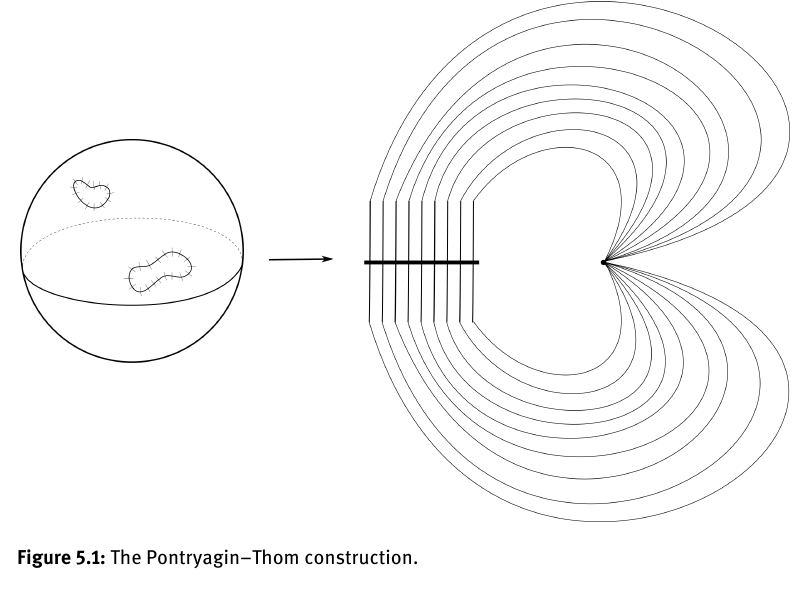
Figure 5.1: The Pontryagin–Thom